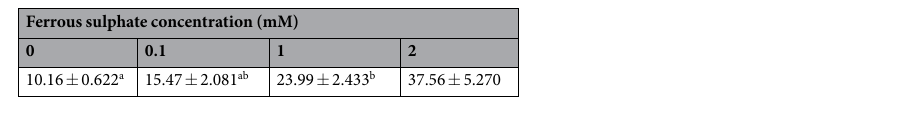
Table 2. Mortality (%) of cells exposed to different concentrations of ferrous sulphate at 48 h. Data are presented as mean ± S.D. The results for the normality and homogeneity are presented in Table S4. A one-way ANOVA with Bonferonni multiple comparison test was performed (Tables S5 and S6). Statistical significance was set as * P < 0.05. Columns with the same superscript are not significantly different at P < 0.05. The data presented are results of three separate experiments with two technical replicates for each